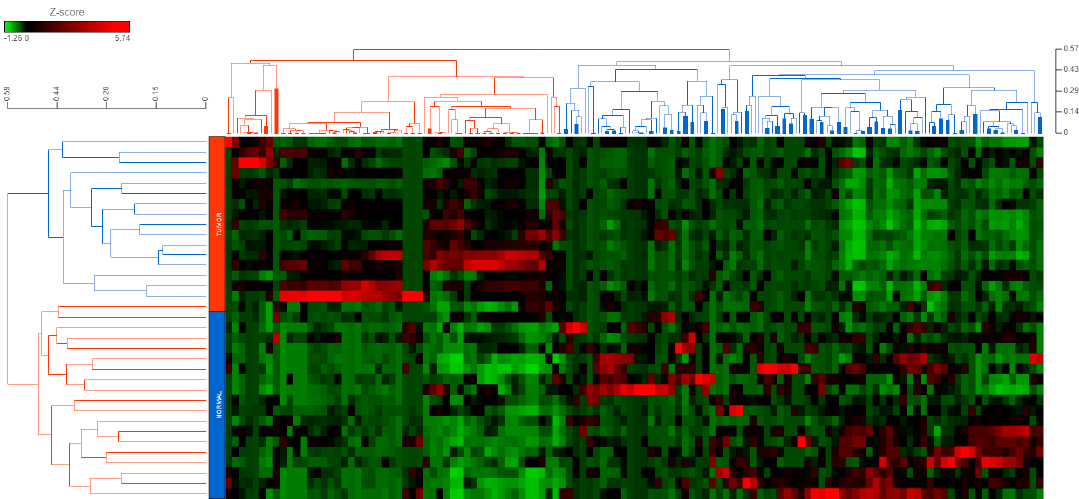
Figure 1. Hierarchical clustering of differentially expressed piRNAs in colorectal cancer. A total of 143 differentially expressed piRNAs ( − 2 ≥ fold-change ≥ 2; p < 0.05) in colorectal cancer (CRC) vs. non-malignant colon tissue were hierarchically clustered together using an average-linkage-based cluster distance metric and Pearson correlation as the point distance metric. Rows represent tissue specimens (Blue—normal tissue; Red—tumor tissue), while the columns represent the differentially expressed piRNAs. As per the Z-score color coding, red represents a high expression, whereas green represents a low expression of a given piRNA.